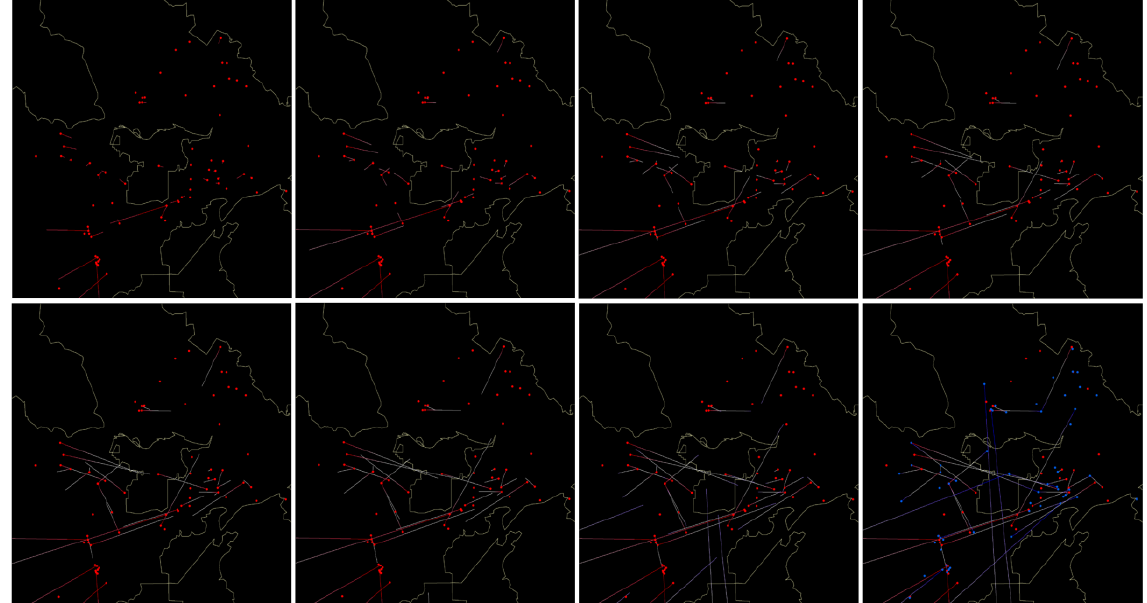
Figure 1. Geovisualization Sprite Frames